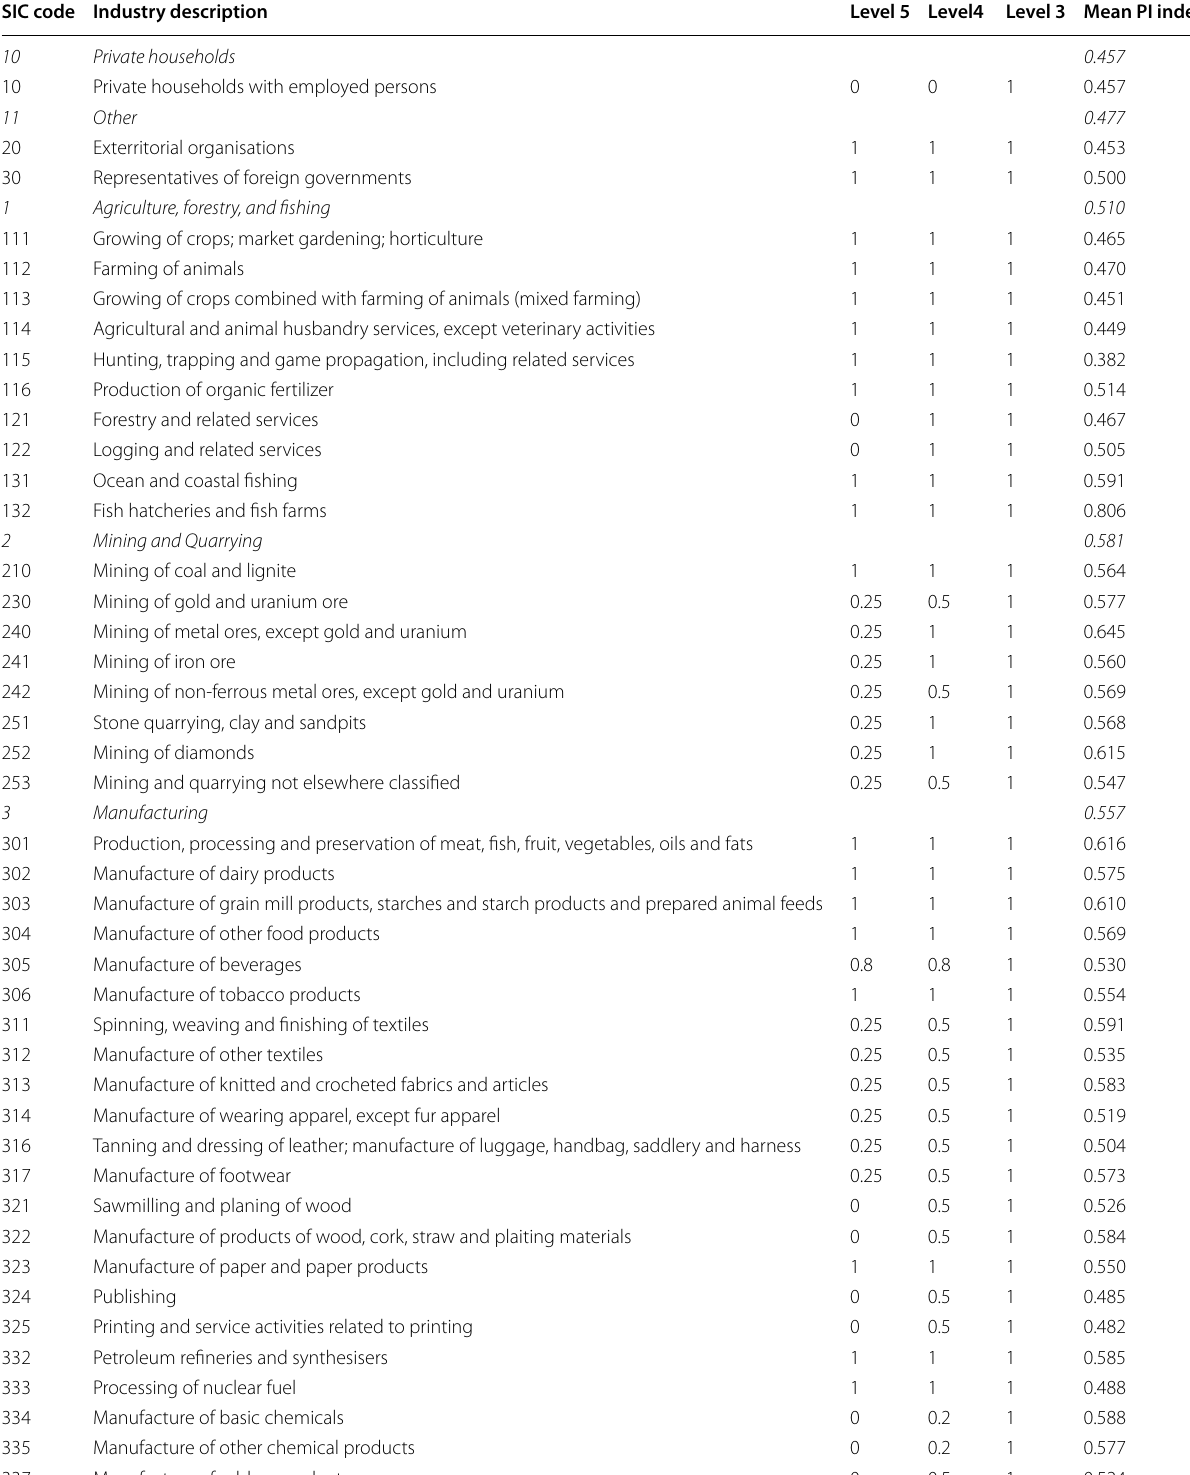
Table 9 Industry-level variation in legislated permission to work, by lockdown level. Author’s own arrangement. Source : COVID-19